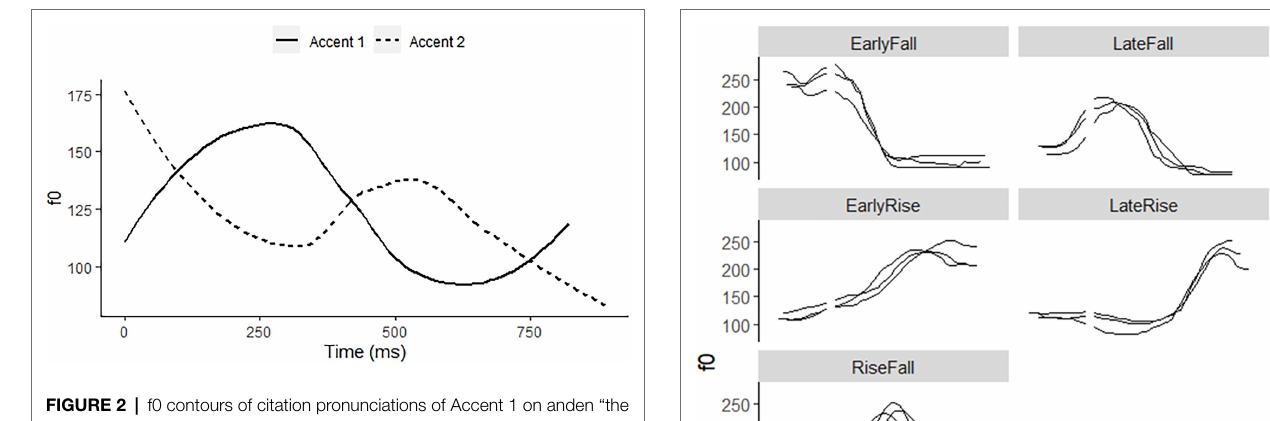
FIGURE 2 | f0 contours of citation pronunciations of Accent 1 on anden “the duck” (solid line) and Accent 2 on anden “the spirit” (dashed line) by a 60-year-old male speaker of Stockholm Swedish.